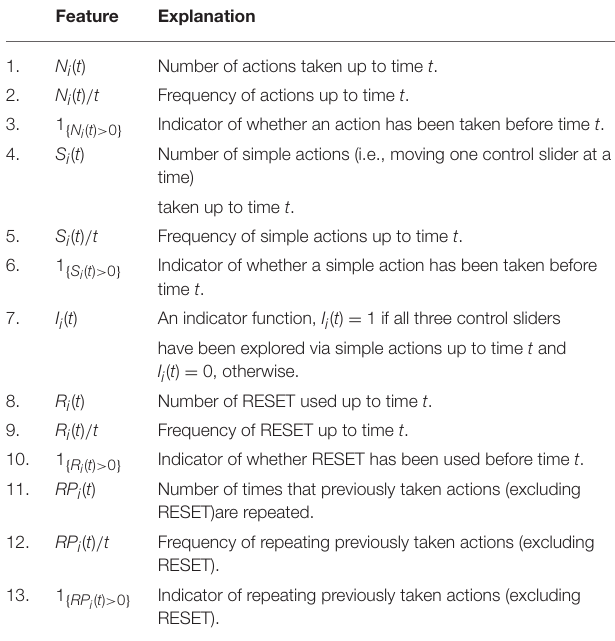
TABLE 2 | The list of candidate features to be incorporated into the model.